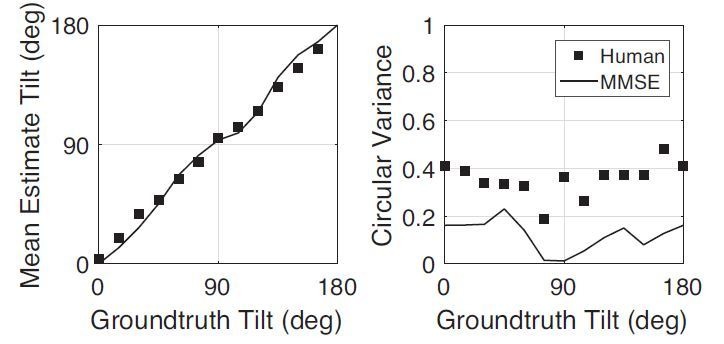
Model performance on artificial stimuli